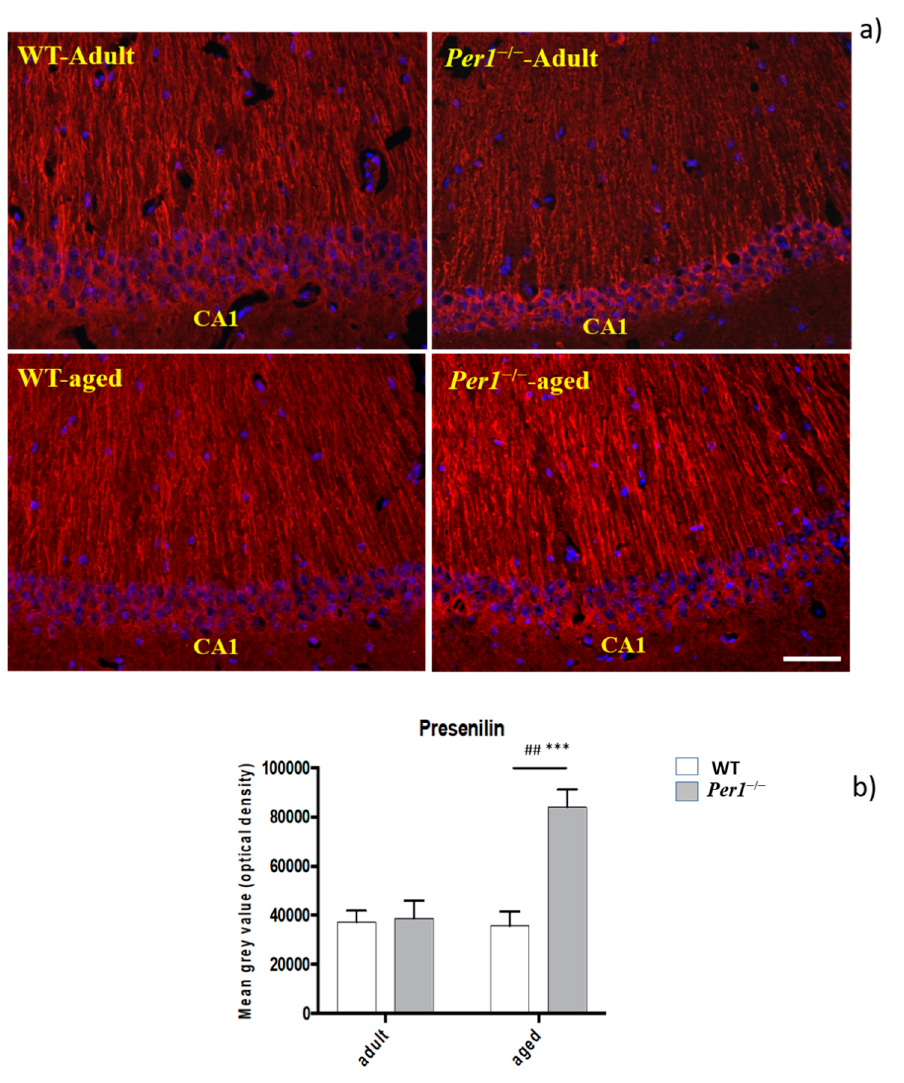
Figure 5. ( a , b ): ( a ) The presenilin immunoreactivity in the hippocampus of aged WT and aged Per1 − / − -mice. ( b ) Densitometric analysis of presenilin immunoreactivity in the hippocampus of WT mice (white scale) and Per1 − / − -mice (grey scale). Significant differences between means were statistically assessed by ANOVA. *** p < 0.001 and ## < 0.01 was considered statistically significant. Scale bar 100 μ m.